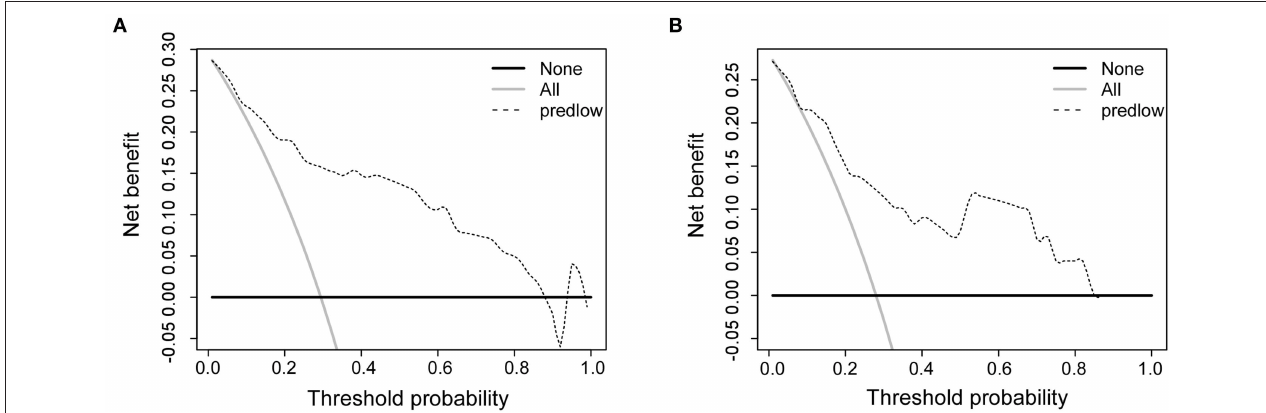
FIGURE 3 | Decision curve analysis comparing the net-benefit of using the nomogram (black dashed line) depicted in (A) training cohort and (B) validation cohort. Black solid line: net benefit when all breast cancer patients are considered as not having the IMLN metastasis; gray solid line: net benefit when all breast cancer patients are considered as having the event. The ideal model is the model with the highest net benefit at any given threshold.